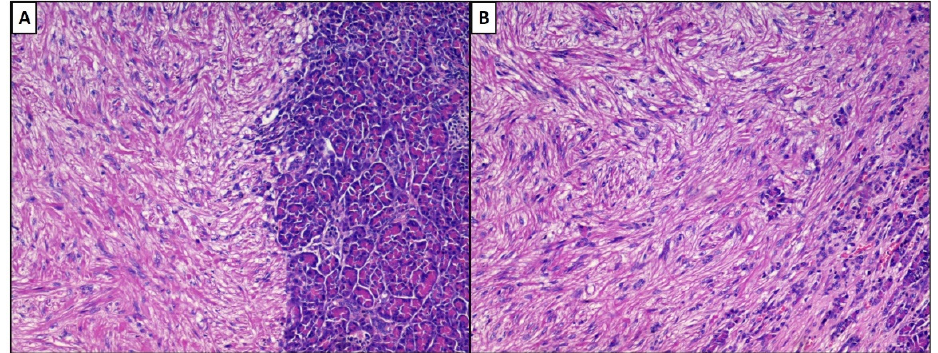
Figure 4. ( A , B ). Histological preparation including metastases in the pancreatic parenchyma (left) of PHLeiomyosarcoma. Note the same growth pattern as the primary lesion (hematoxylin–eosin, original magnification: 10× ( A ) and 20× ( B ).